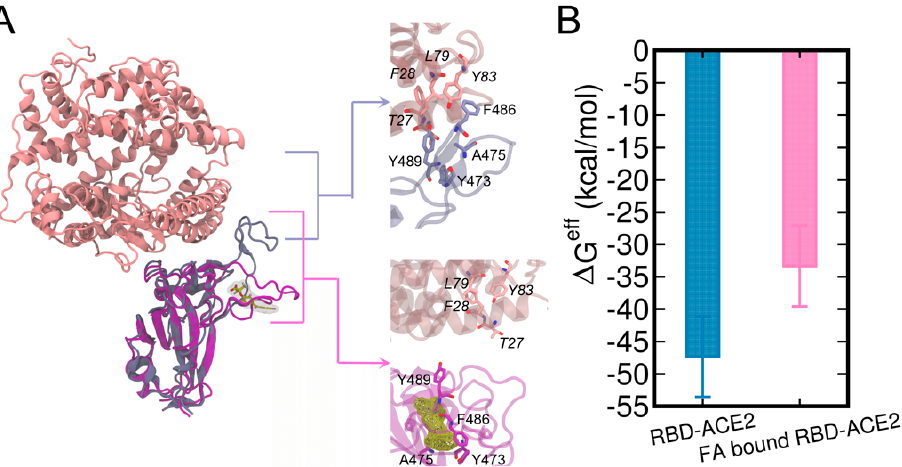
Figure 6. RBD-ACE2 complex and FA-bound RBD-ACE2 complex are aligned by the RBD ( A ). The structures of ACE2 and RBD are shown in pink and ice blue cartoons while the FA-bound RBD is shown in purple, respectively. FA molecule is shown in the yellow meshed surface. The effective binding free energies ( Δ G eff ) [66] calculated using the MM/GBSA method are also shown ( B ).